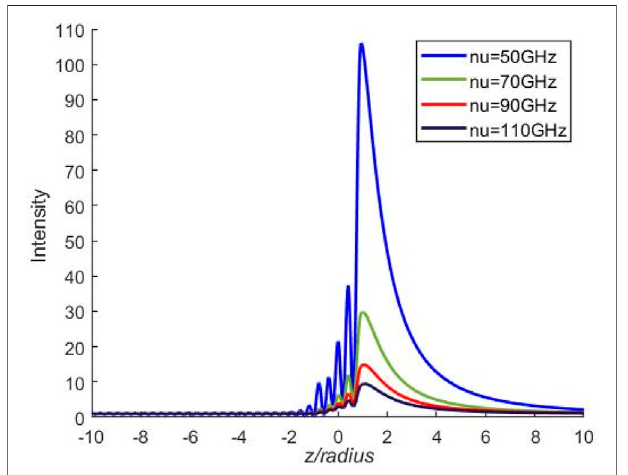
FIGURE 8 | The effect of different collision frequencies and plasma frequencies on the maximum intensity of the focal spot at f i = 2.1 GHz.